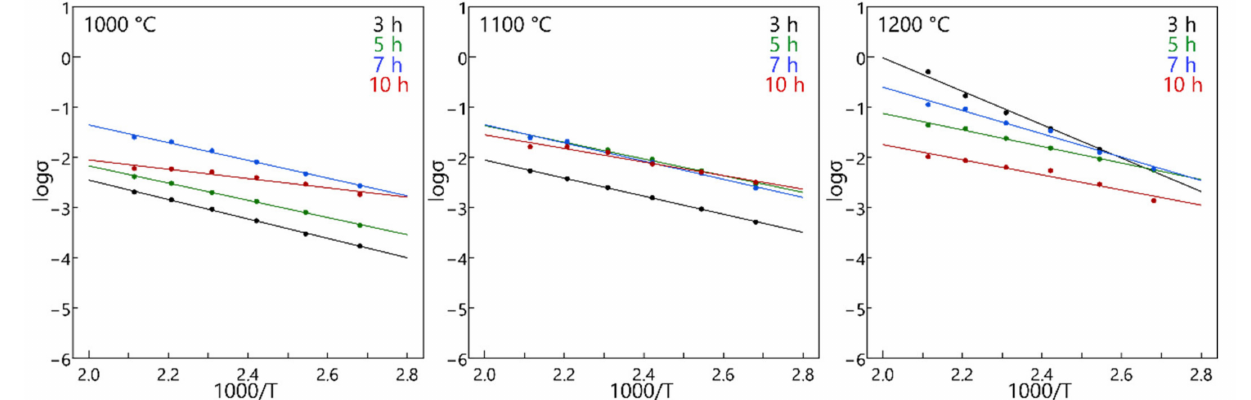
Figure 9. Arrhenius plots for electrical conductivity of the LPS-NZSP.